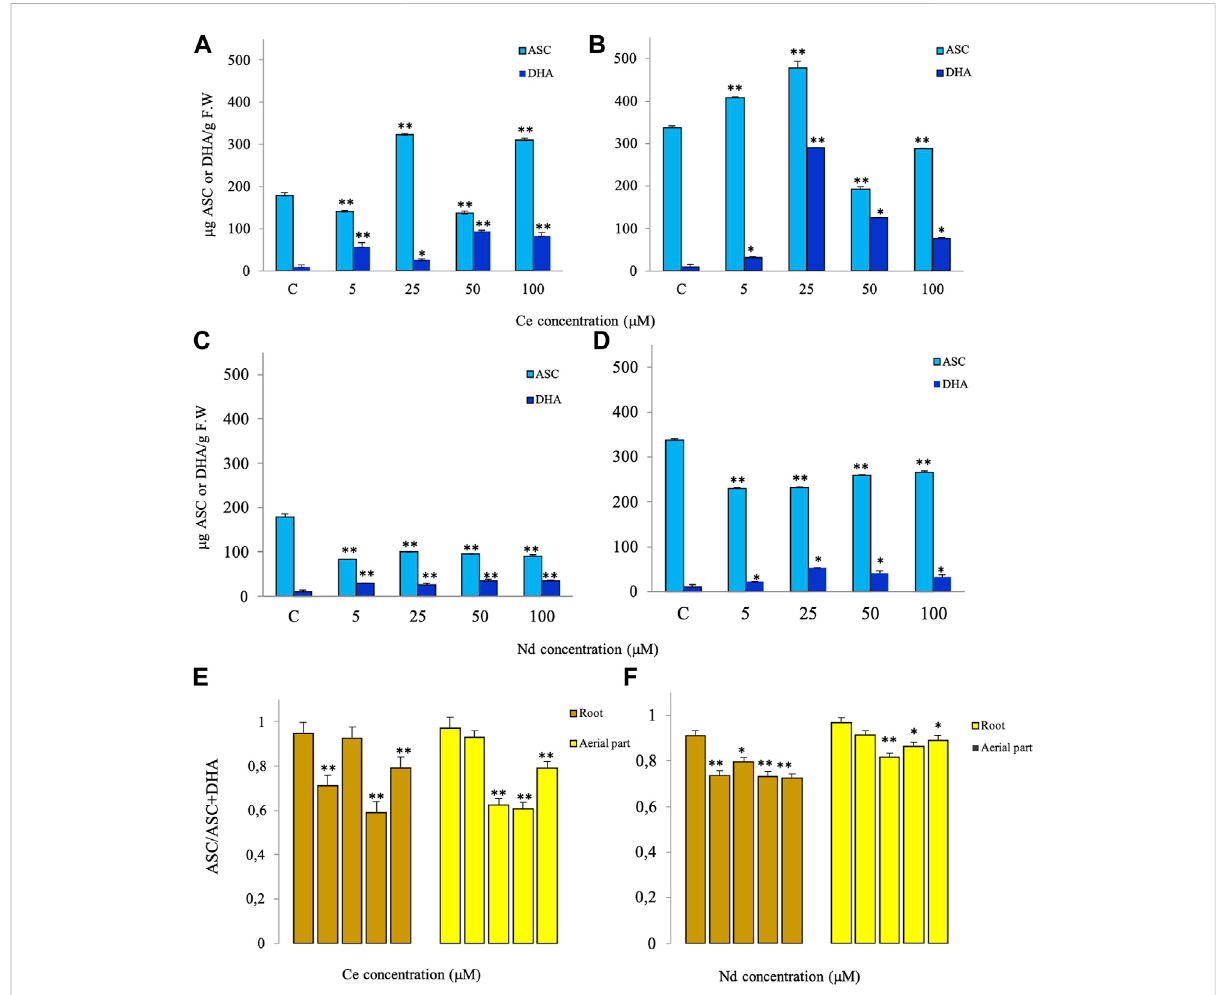
FIGURE 3 Effects of different concentrations of Ce (A,B) and Nd (C,D) on the contents of ascorbate (ASC) and dehydroascorbate (DHA) after 3 days of treatment in roots (A,C) and aerial parts (B,D) and the ratio of ASC/ASC + DHA (E,F) of lentils. Vertical bars indicate the SD of three replicates in